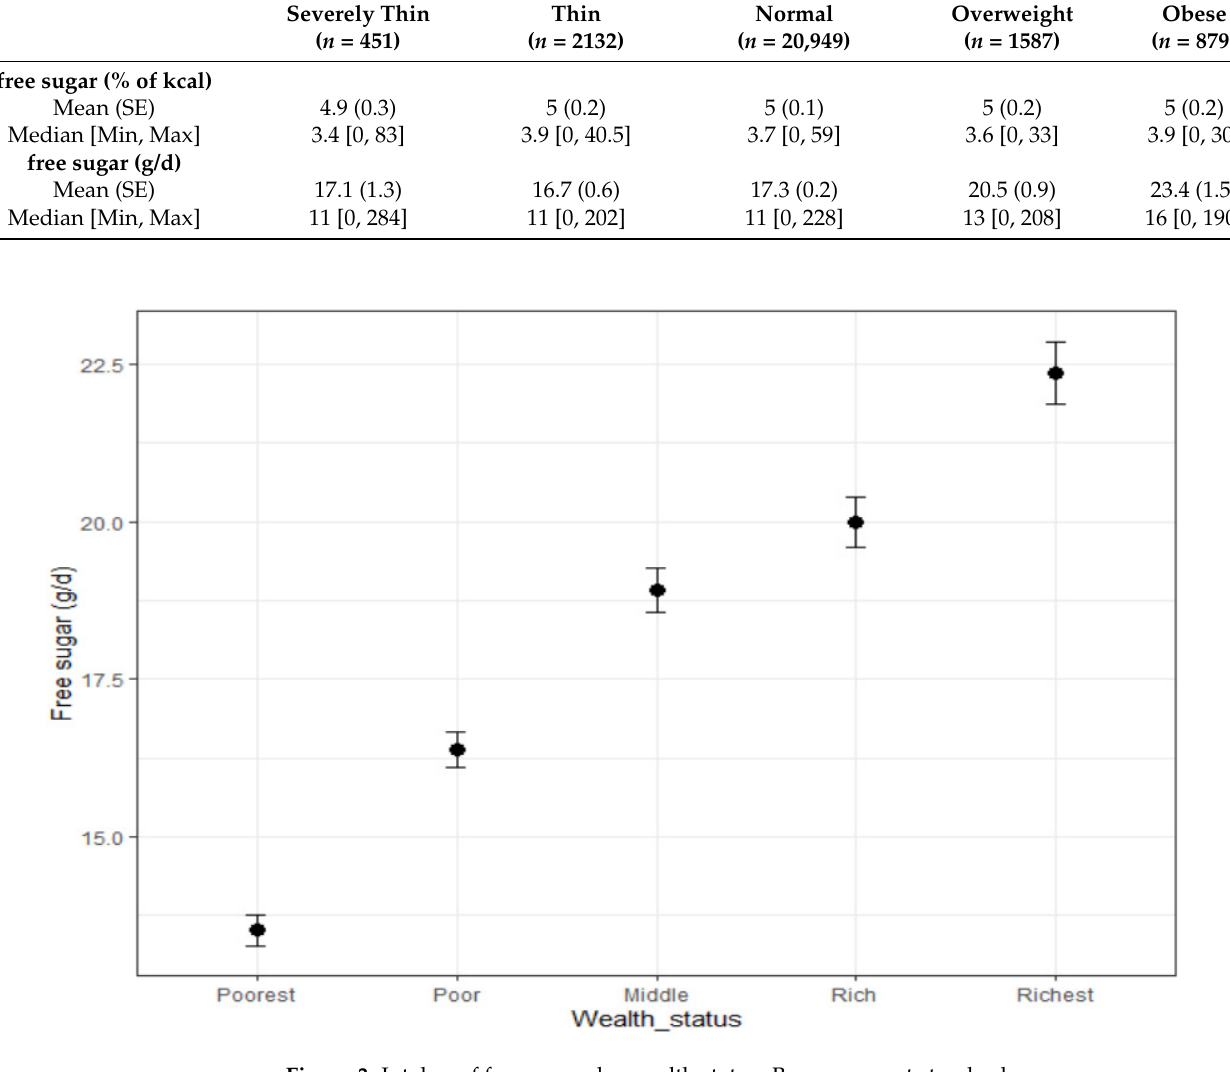
Figure 3. Intakes of free sugars by wealth status. Bars represent standard errors. Table 10. Intakes of free sugars by wealth status.